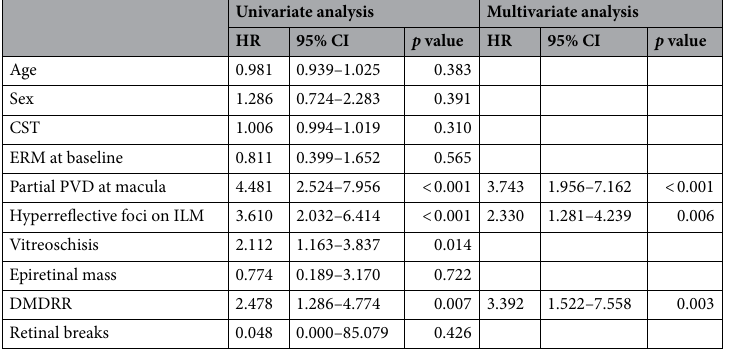
Univariate analysis Multivariate analysis